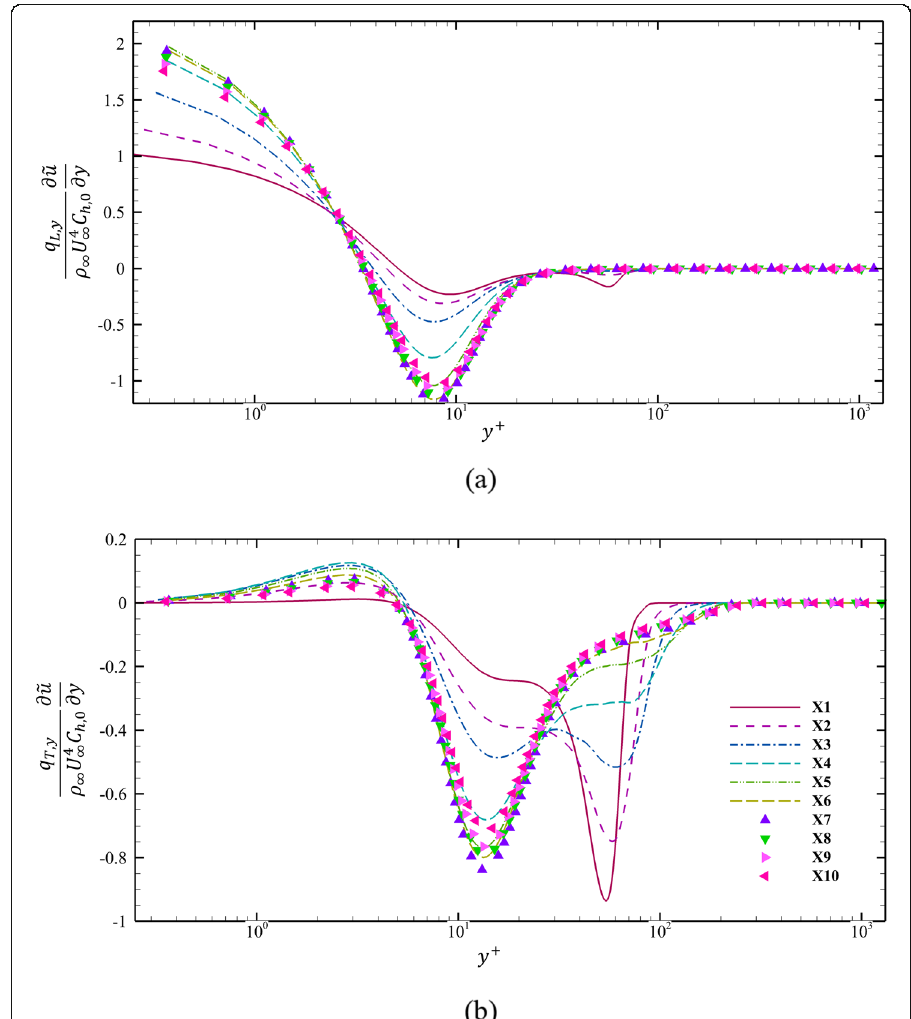
Fig. 6 The distribution of the integrand functions of the contributions of ( a ) the heat conduction C h ,2 and ( b ) the turbulent transport C h